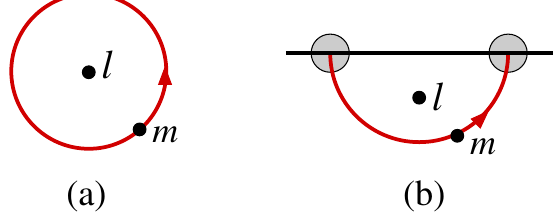
FIG. 4. (a) The concept of braiding nondegeneracy in the bulk : If l is a quasiparticle that cannot be annihilated in the bulk, then there must be at least one quasiparticle species m that has nontrivial mutual statistics with respect to l , i.e., e i(cid:3) lm (cid:1) 1 . (b) The concept of braiding nondegeneracy at a gapped edge : If l cannot be annihilated at the edge, then there must be at least one quasiparticle m that can be annihilated at the edge such that e i(cid:3) lm (cid:1) 1